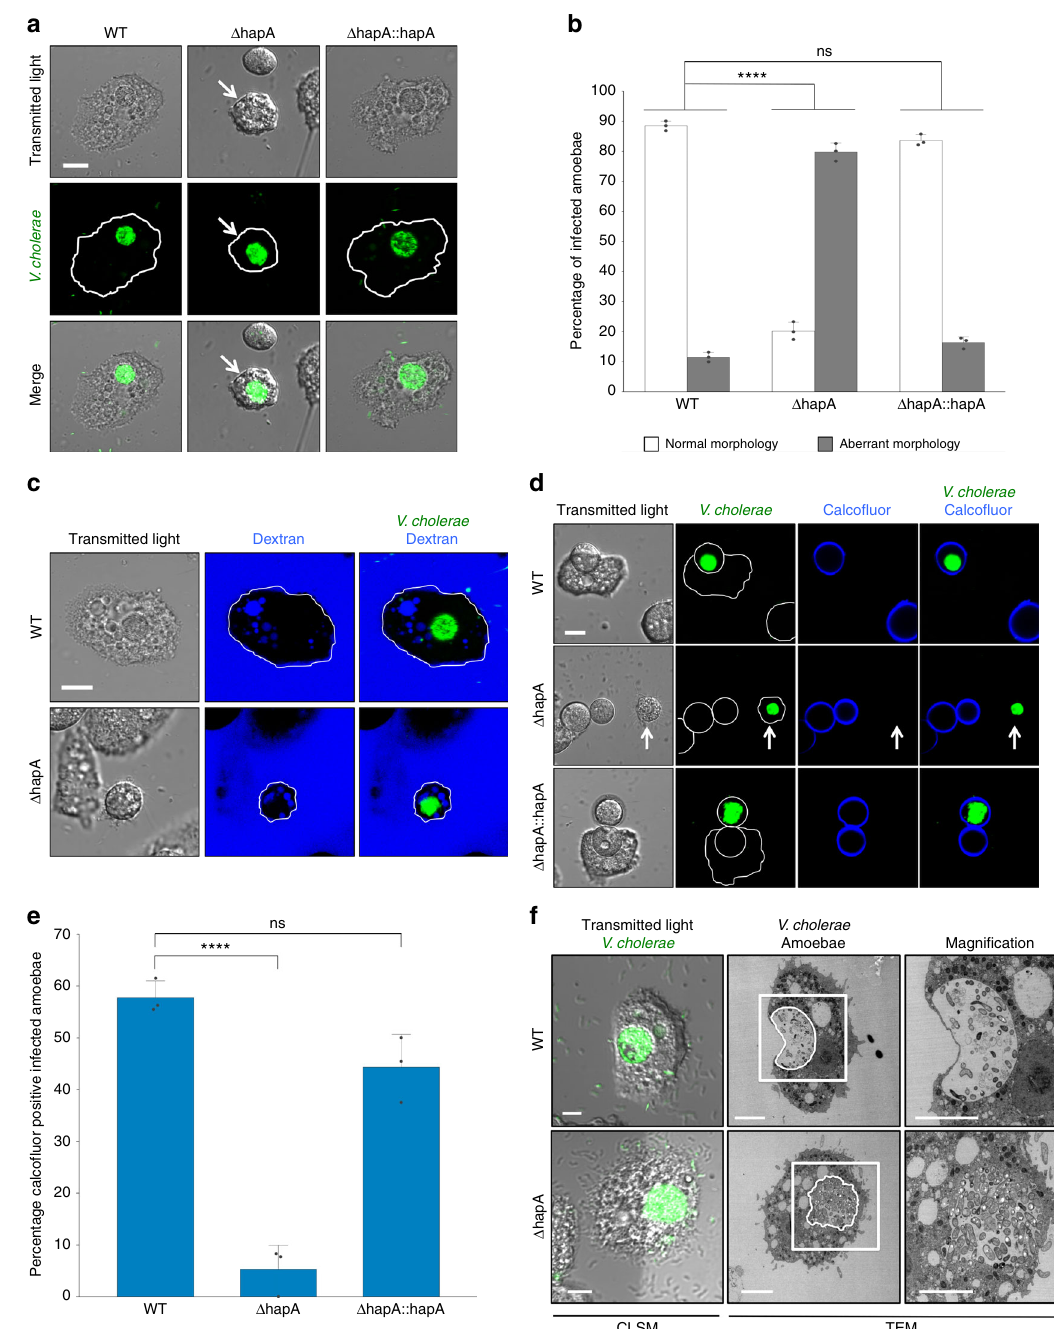
Fig. 2 Hemagglutinin protease-de fi cient V. cholerae strains intoxicate amoebal trophozoites. a CLSM images of amoebae that were colonized by GFP- tagged wild-type (WT), hapA -minus ( Δ hapA), or the hapA complemented ( Δ hapA::hapA) V. cholerae strains at 20 h p.p.c. Shown are the transmitted light channel (top), the green channel (middle), and the merged image of both channels (bottom). The white arrows highlight the aberrant morphology of the intoxicated amoeba. b Quanti fi cation of normal and aberrant morphologies of amoeba infected with any of the three bacterial strains mentioned in a . c Protease-de fi cient V. cholerae mutants do not co-localize with dextran-labeled digestive vacuoles. Labeling of the endosomal pathway using fl uorescent dextran shows the residence of WT (top) and Δ hapA (bottom) strains inside the dextran-negative CV. d Cellulose is not deposited around amoebae infected with hapA -minus bacteria at 30 h p.p.c. Amoebae infected with WT, Δ hapA, or the hapA complemented strain ( Δ hapA::hapA) were stained with calco fl uor to visualize deposited cellulose around the cysts. The white arrows point towards a cellulose-de fi cient A. castellanii infected by the hapA -minus strain. e Quanti fi cation of the calco fl uor-stained infected amoebae. Bacterial strains correspond to those in d . f CLEM images of WT- and hapA -minus- infected amoebal trophozoites (details as in Fig. 1). Scale bars: 10 µ m ( a , c , d ) and 5 µ m ( f ). All graphs show the averages of three independent biological replicates (±s.d., as shown by the error bars). Statistics are based on a one-way ANOVA. *** p ≤ 0.001; ns (not signi fi cant), p >